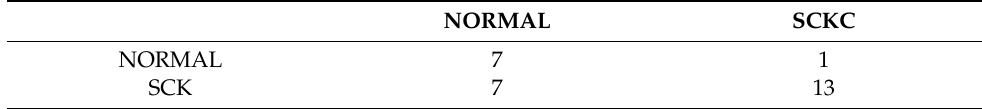
Table 3. Decision Tree. Confusion matrix. Prediction vs